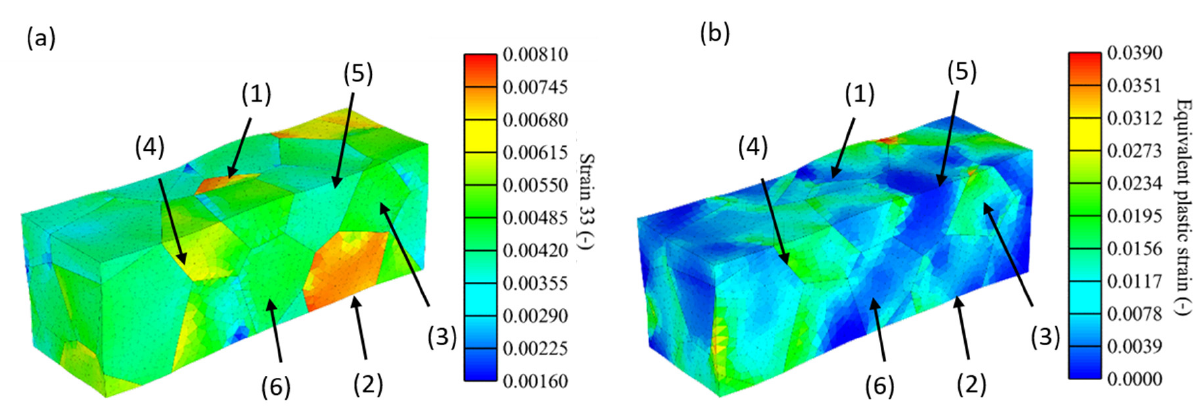
Figure 5. ( a ) Elastic strain S33 in loading direction and ( b ) equivalent plastic strain for a randomly orientated specimen.